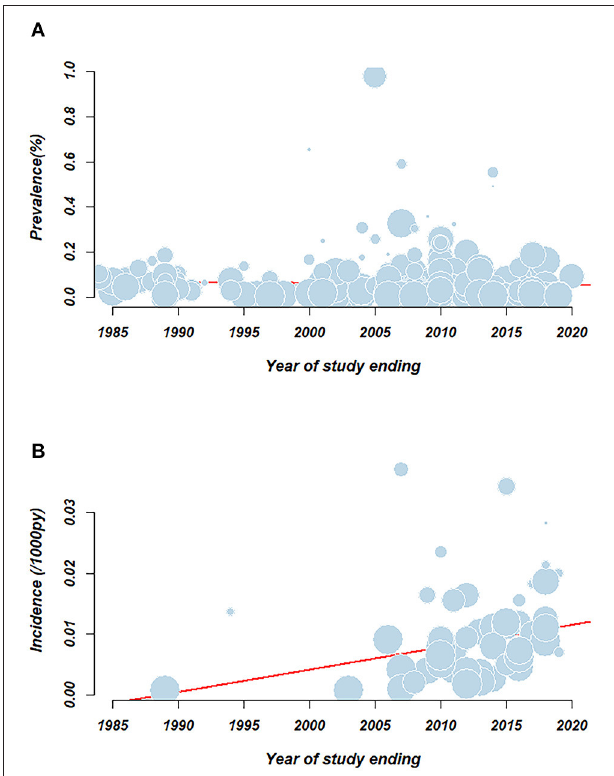
FIGURE 3 | Meta-regression examining the association between pooled rate and study year. (A) HCV prevalence; (B) HCV incidence. Circles represent individual record. Size of the circle represents the relative weighing of each record. Red line represents the linear regression